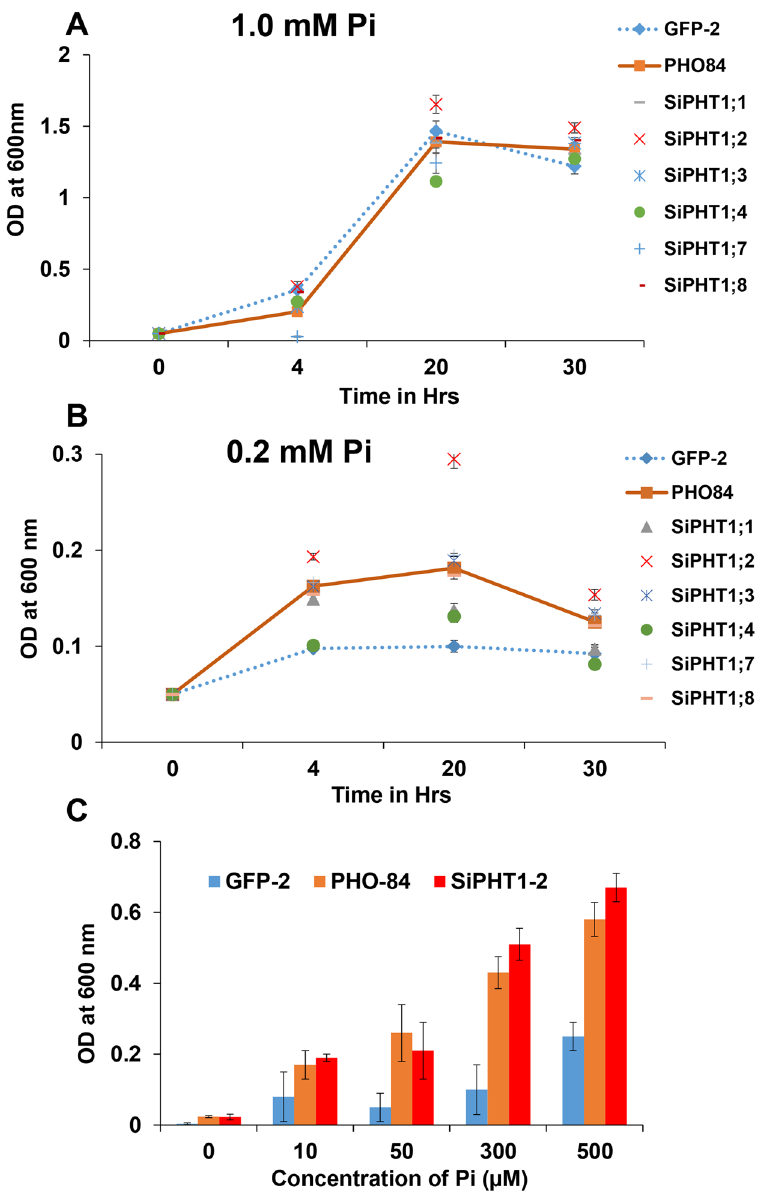
Figure 1. Complementation of S . cerevisiae pho84 mutant with foxtail millet PHT1 transporters. Growth curves of S. cerevisiae pho84 Δ mutant transformed with the indicated foxtail millet SiPHT1 transporters, empty vector (GFP-2 dotted line) and S . cerevisiae PHO84 (solid line) under 1.0 mM Pi ( A ) and 0.2 mM Pi Pi ( B ). Assay of growth of pho84 Δ mutant cells transformed with SiPHT1 ; 2 , ScPHO84 or empty vector (GFP-2) in different concentrations of Pi ( C ). The OD 600 was measured after 20 hrs of growth. All the values are expressed as mean ± SD of 3 replicates and 2 repeats. The initial OD 600 cultures were adjusted to have the starting of